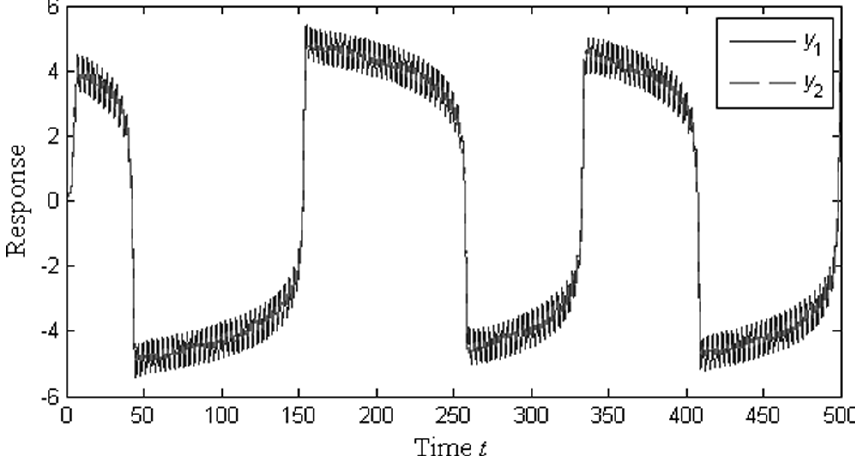
Fig. 23. Time history with feedback control, τ = 0, ( y 1 ,y 2 , ˙ y 1 , ˙ y 2 ) = (0.01,0.01,0,0).